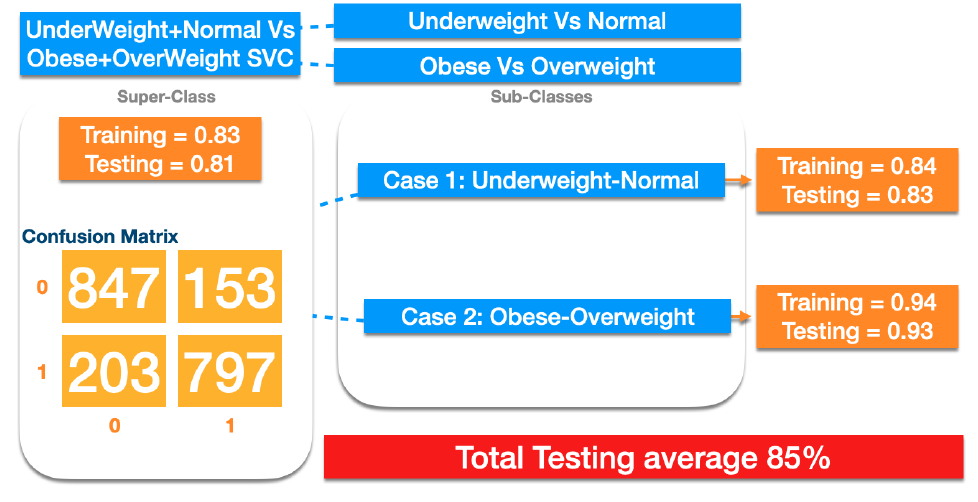
Figure 11. Cascaded SVC system.